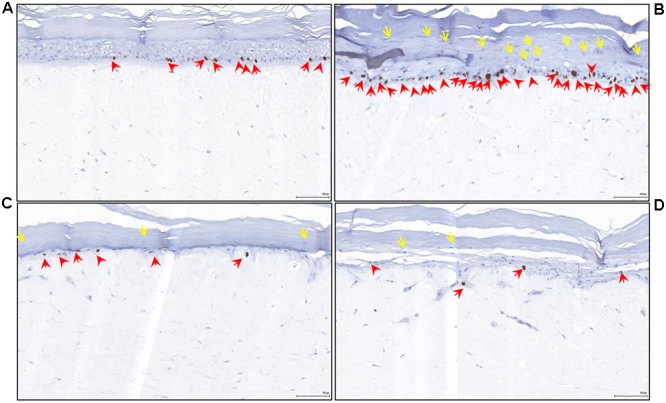
East Indian Sandalwood Oil treatment (4 days) reverses epidermal inflammation and hyperproliferation in psoriatic skin model. Reconstituted normal and psoriatic skin samples were cultured in media ±EISO. Immunohistochemical staining of reconstituted psoriasis tissue model showing Ki67 as marker of proliferation restricted to the stratum basale layer (red arrows). (A) Reconstituted normal skin 3D cultures, (B) untreated psoriatic skin, (C) psoriatic skin +0.001% EISO, (D) psoriatic skin + 0.002% EISO after 4 days. In addition, the increased keratinocyte nuclei observed in stratum corneum of psoriatic epidermis (yellow arrows) is decreased in EISO treated psoriatic skin cultures. These nuclei are indicative of impaired terminal differentiation of keratinocytes. Scale bar = 100 μm.